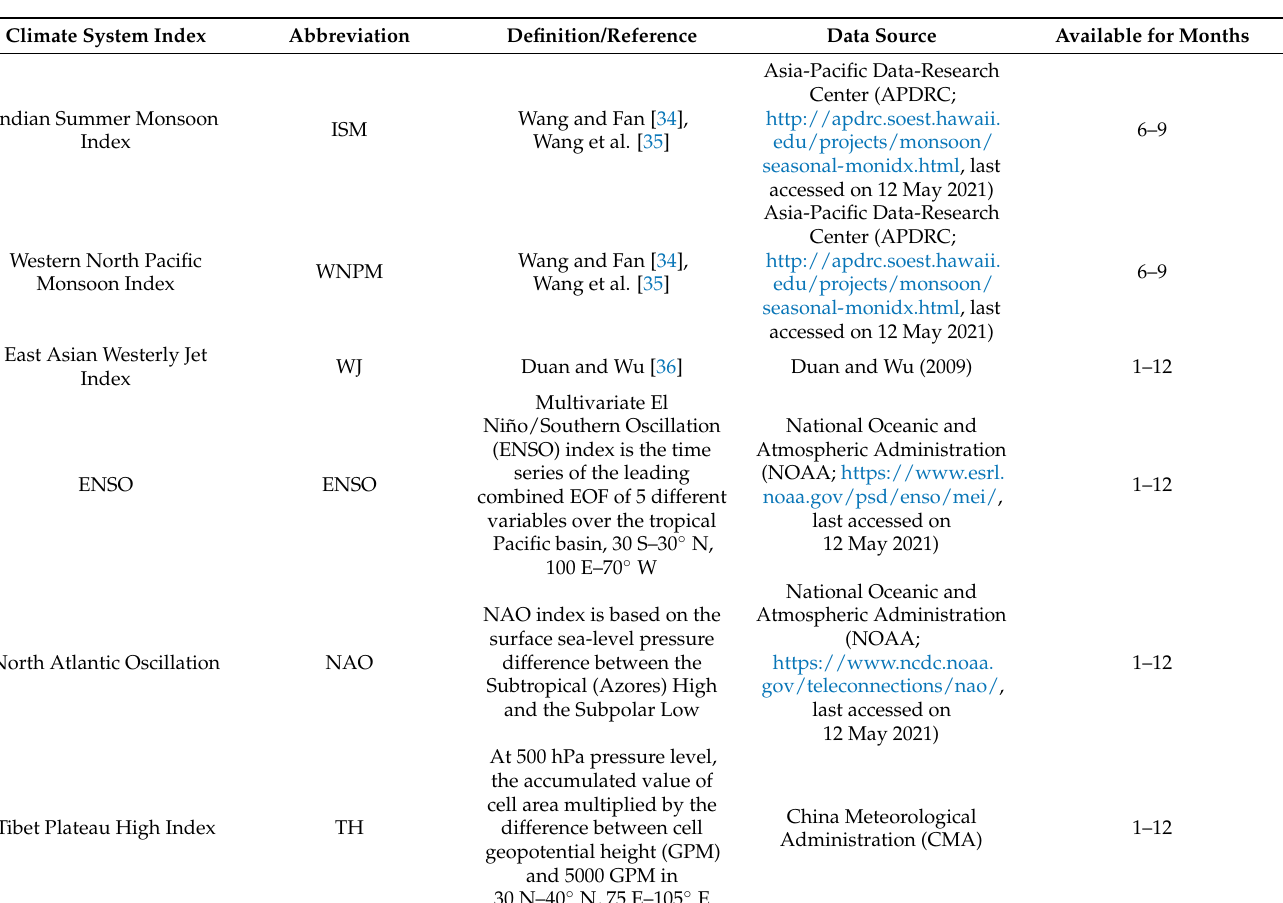
Table 2. Selected climate system